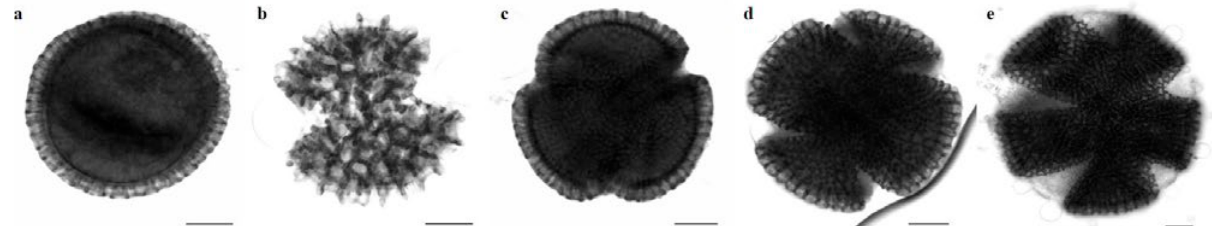
Fig. 5. Pollen grains types in L. algarvense . Pollen grains with one colpus ( a ), two ( b ), three ( c ), four ( d ) and five ( e ) colpi. Bars = 5